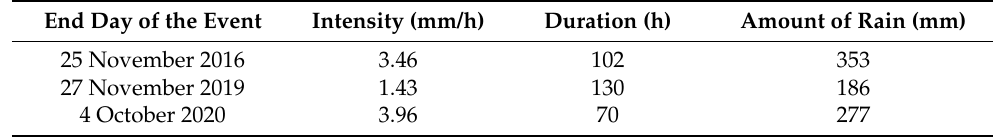
Table 4. Rainfall events associated with major reactivations.